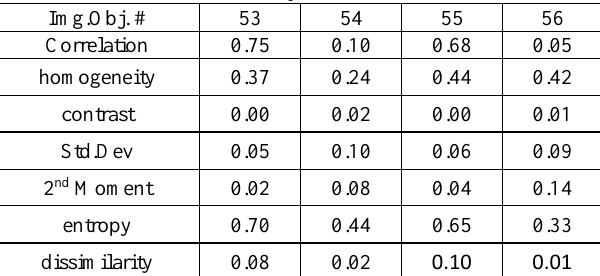
Table 3. Post-event feature values for four sample image objects.